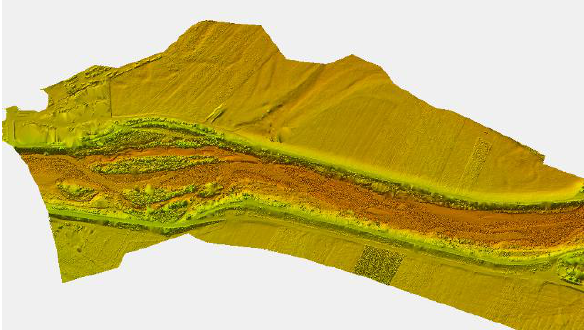
Figure 5: Generated mesh based on a filtered dataset with focus on displaying the high resolution of the riverbed